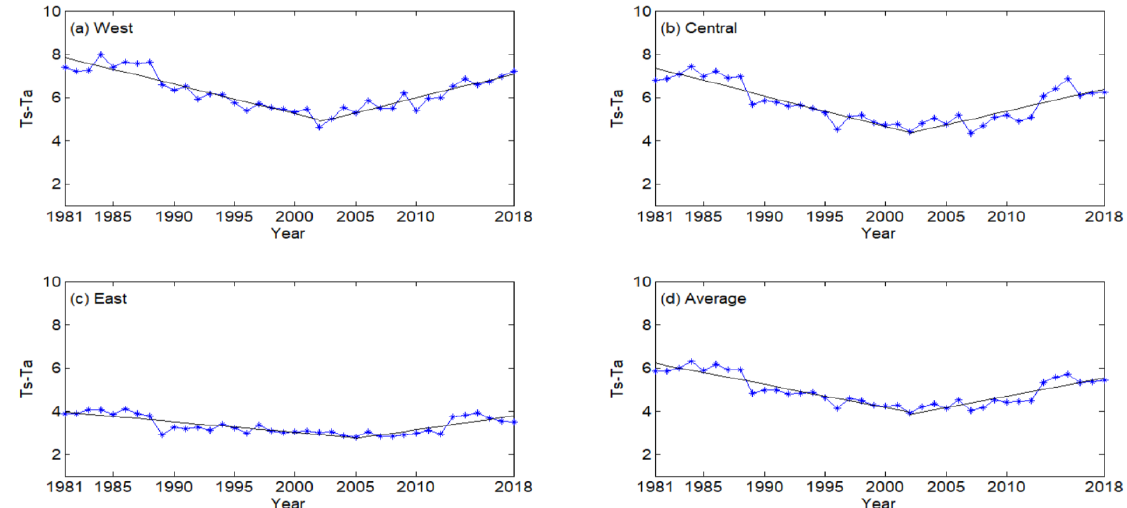
Figure 6. Variations in annual Ts-Ta (°C) in the Noah-MP simulation for the western ( a ), central ( b ), eastern ( c ), and entire TP ( d ) during the period 1981 – 2018. All of the trends are derived from linear least – squares regressions and are significant at the 95% confidence level using the Mann – Kendall trend test.